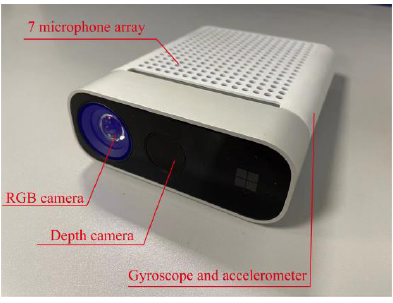
Figure 2. Microsoft Azure Kinect